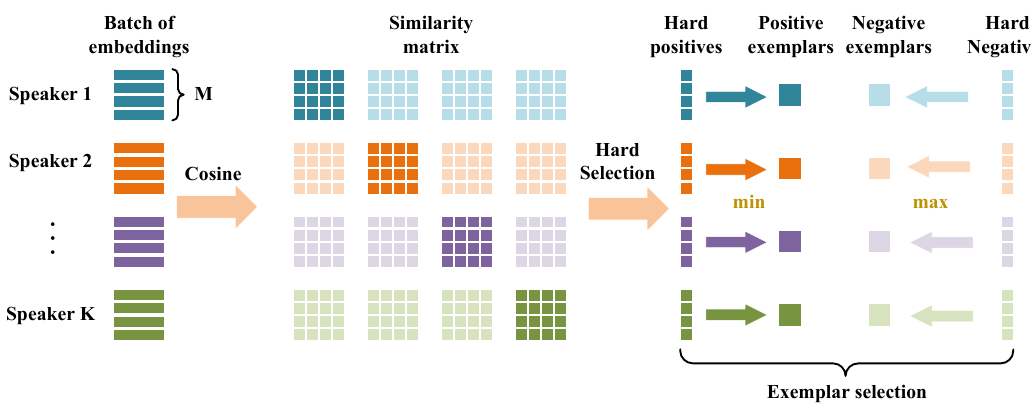
Figure 1. Diagram of the online exemplar mining method for cluster-range